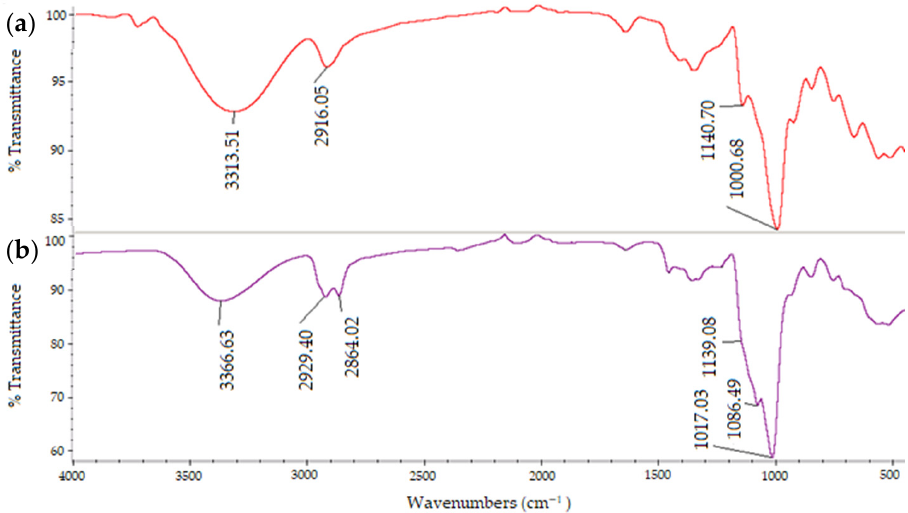
Figure 5. Typical FTIR-ATR spectra of a ( a ) native pullulan and ( b ) BMO-PUL.